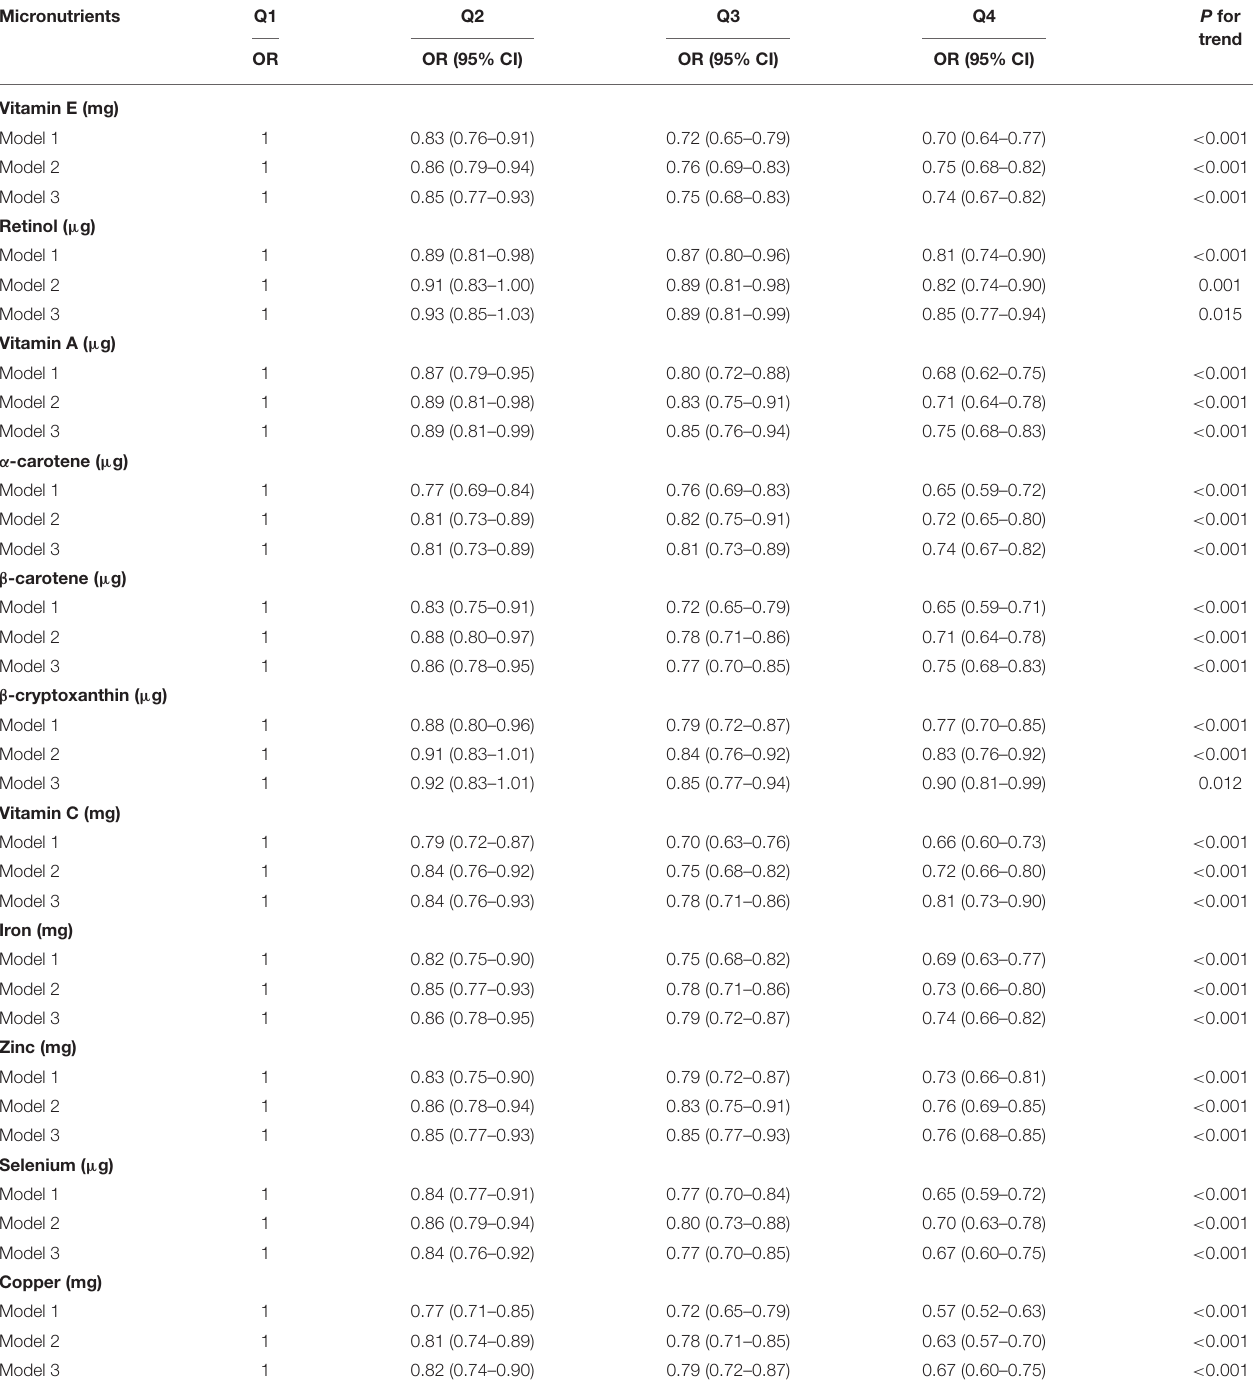
TABLE 2 | Adjusted regression coefficients with 95% confidence intervals (95% CIs) in a multiple regression analysis for total CVD model and 11 dietary antioxidant micronutrients in adults from the United States, collected from the National Health, and Nutritional Examination Survey (NHANES) database, 2003–2018.